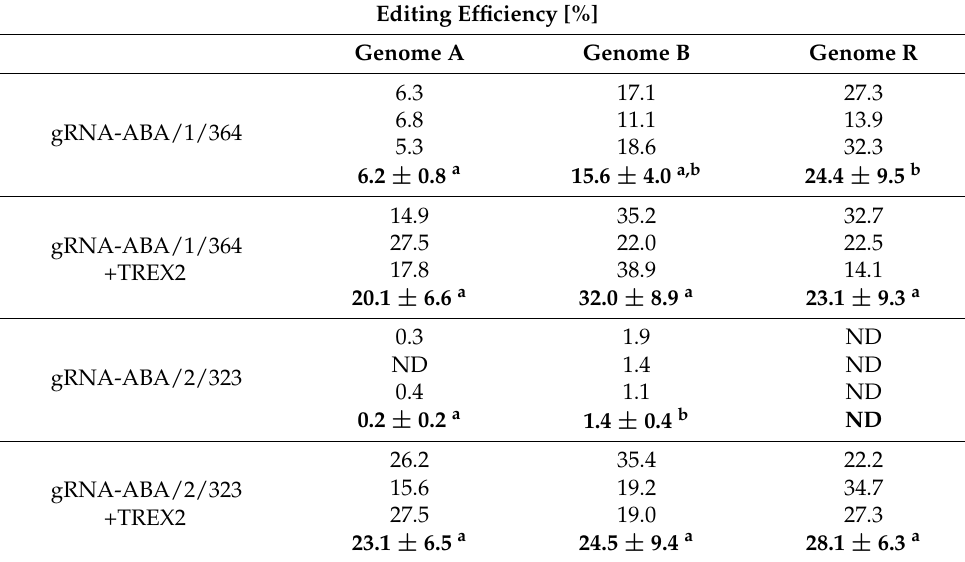
Table 3. Gene editing efficiency for gRNA-ABA/1/364 and gRNA-ABA/2/323 vectors containing or lacking the TREX2 component, analyzed in transfected triticale protoplasts using T7E1 assay. Mean editing efficiency values ± SD indicated in bold letters. ND—not